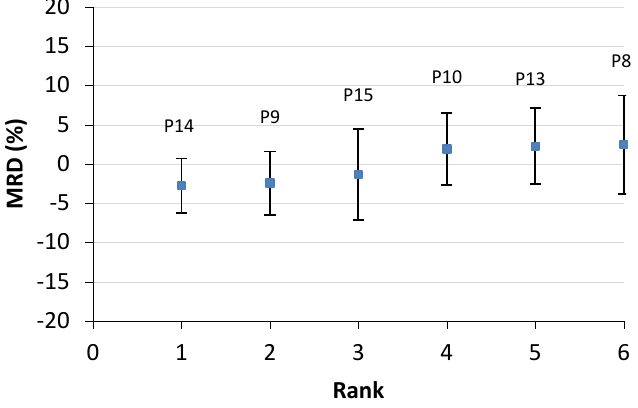
Figure 8. MRD plot for the screened AMSR-E VUA pixels (descending overpass) Pixel numbers are shown in Figure